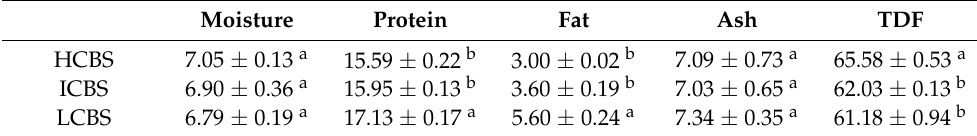
Table 1. Effect of particle size on chemical composition values of cocoa bean shell